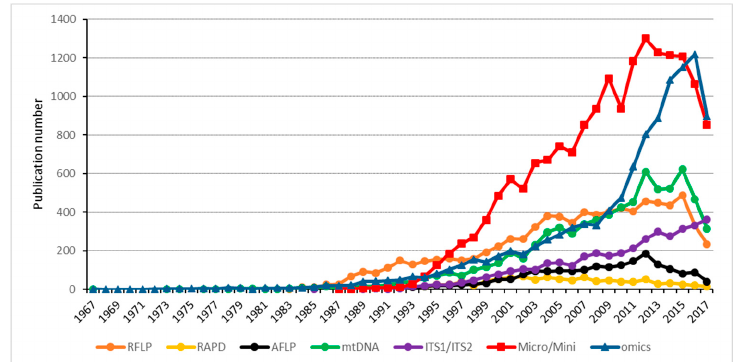
Figure 2. Hits of the search terms in the PubMed data base sorted by year of publication between 1967 and 2017. The -omics techniques, despite their relatively recent appearance and relatively high cost in comparison to other techniques, are increasingly popular. Analysis of micro- and minisatellites is still popular. The search terms were as follows: “Restriction fragment length polymorphism, RFLP analysis AND population genetic” for RFLP, “RAPD analysis AND population genetic“ for RAPD,